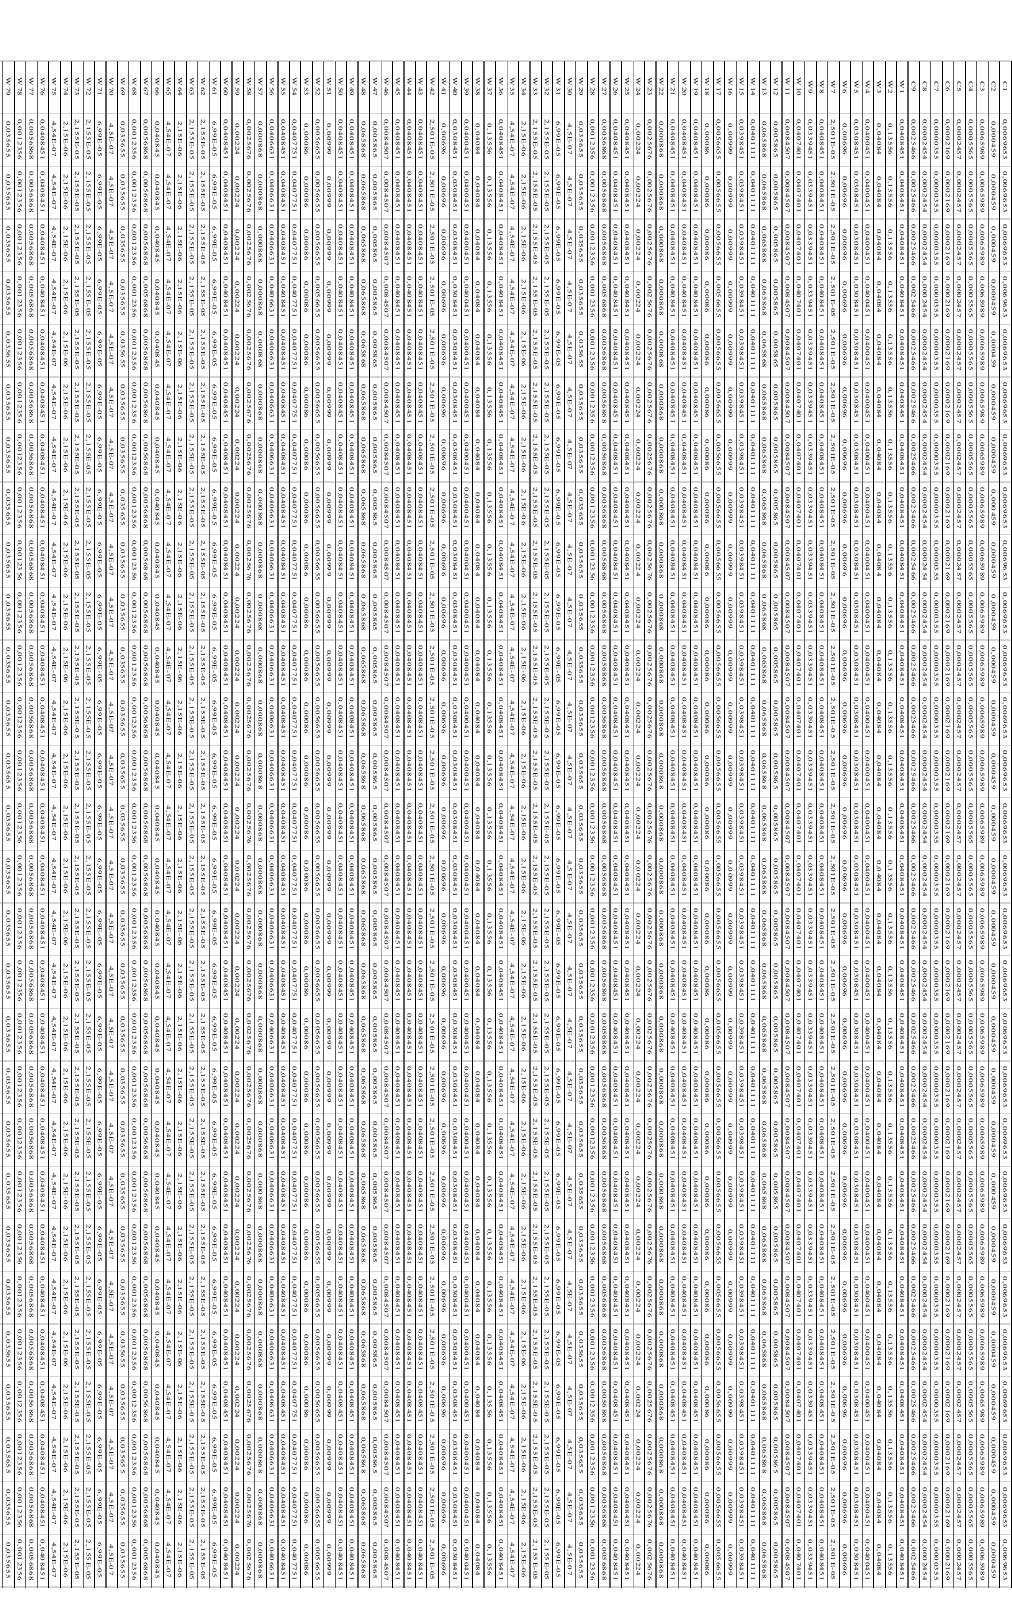
Figure A1. Limit super matrix of the ANP calculations